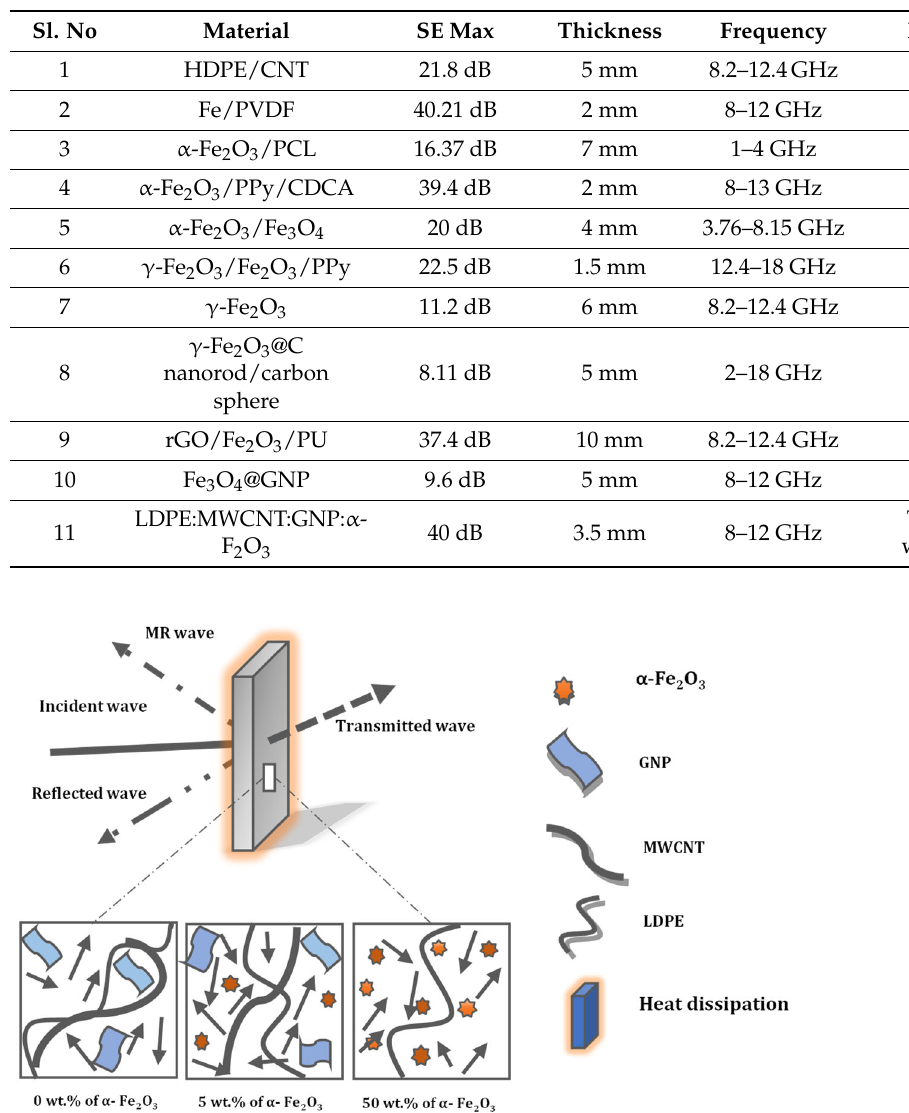
Table 2. Comparison of performance of various composites in the literature with the present work.